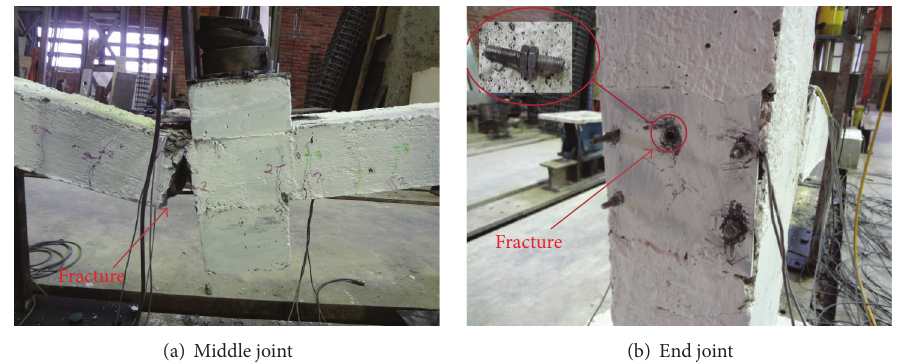
Figure 6: Fracture of bars. (a) Middle joint. (b) End joint.